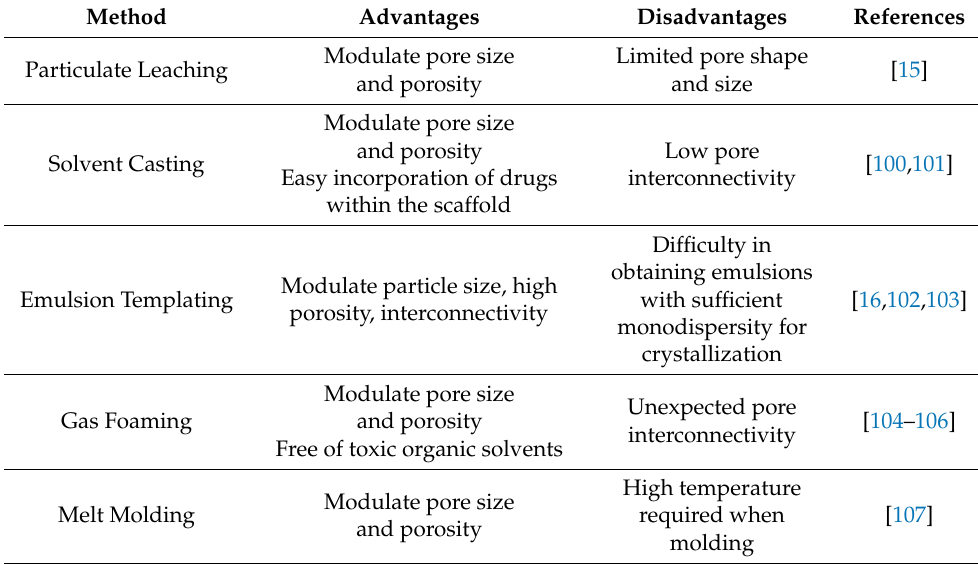
Table 3. Fabrication of porous scaffolds: advantages and